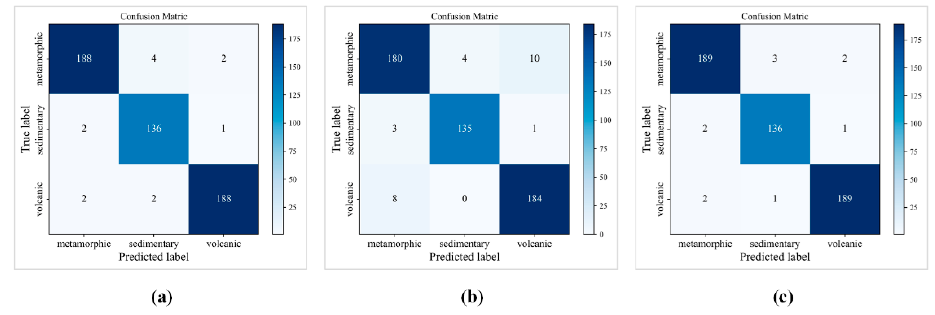
Figure 12. Confusion matrixes: ( a ) RMSprop optimizer; ( b ) SGD optimizer; ( c ) Adam optimizer.